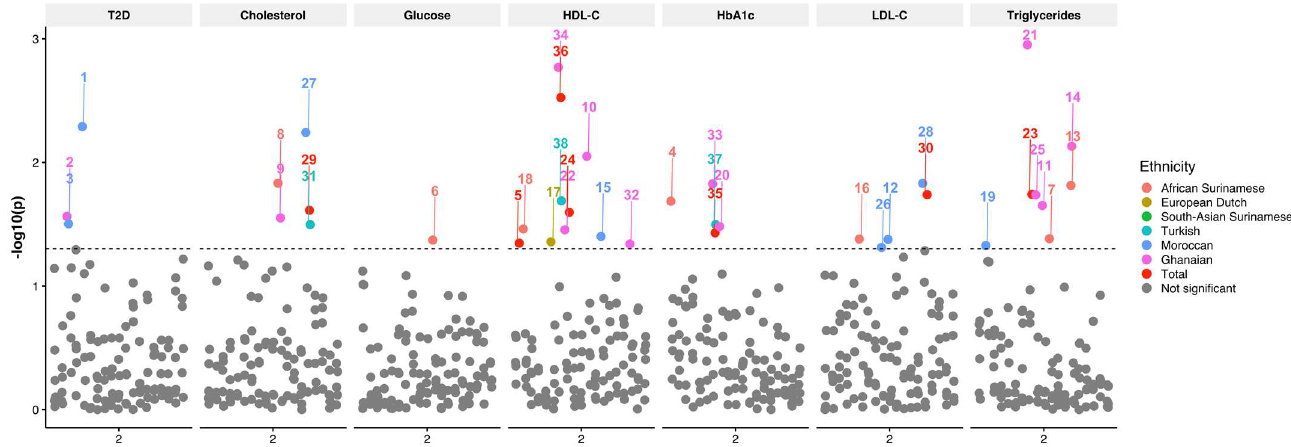
Figure 2 . Manhattan plot of FHL2 SNPs associated with T2D, total cholesterol, glucose, HDL-C, HbA1c, LDL-C, and triglycerides. The X-axis depicts the chromosome. The Y-axis depicts the −log 10 (p) of the corresponding p -value. The different colors indicate the results per group with African Surinamese (orange), European Dutch (macaroon), South Asian Surinamese (green), Turkish (blue), Moroccan (dark blue), Ghanaian (purple), total cohort (red), and not significant (gray). Table 3. Summary results of FHL2 SNPS associations in HELIUS cohort.